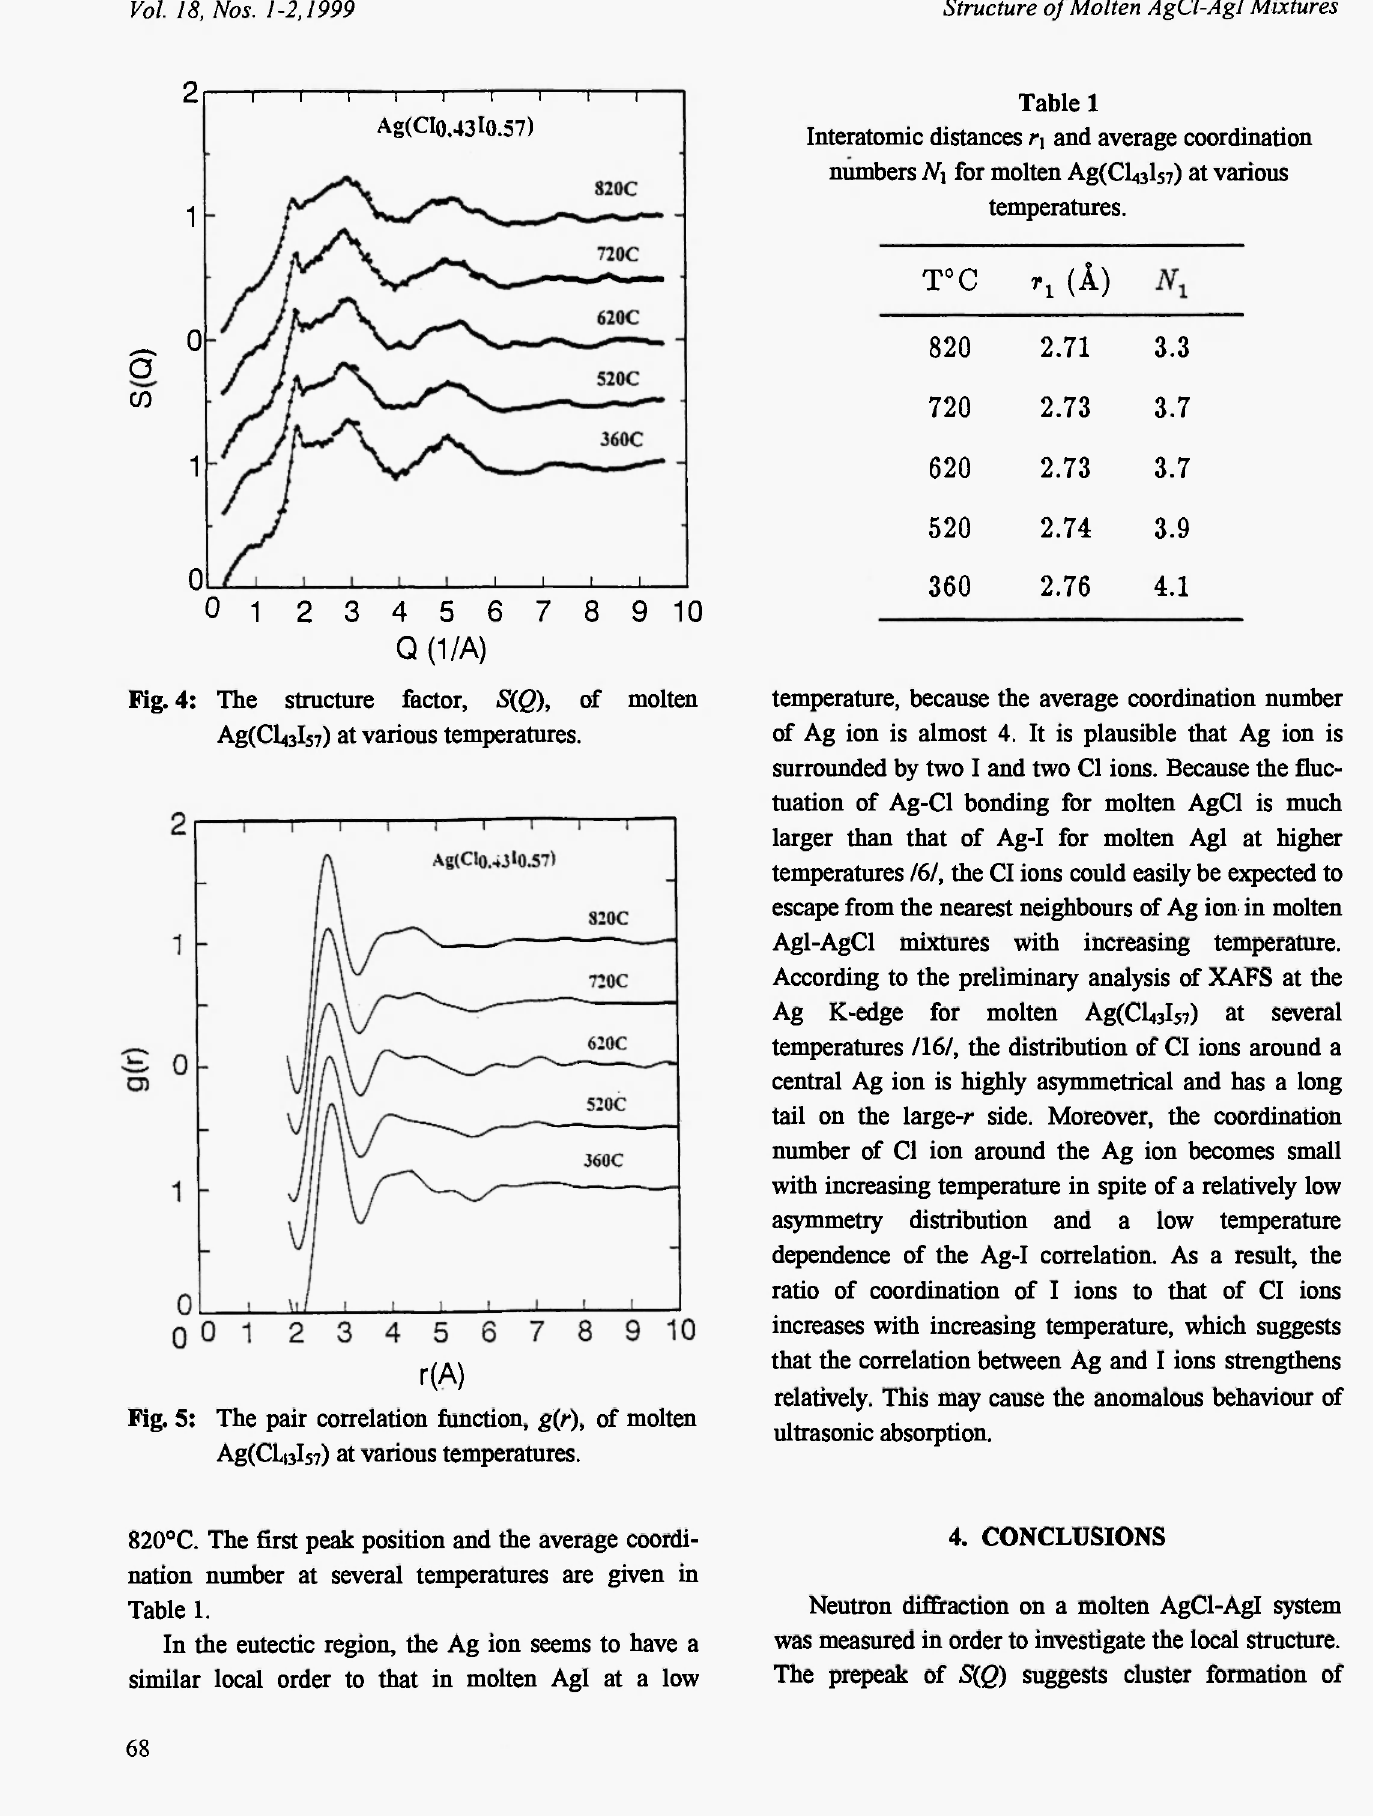
Interatomic distances r\ and average coordination numbers N\ for molten Ag(CLi3l57) at various